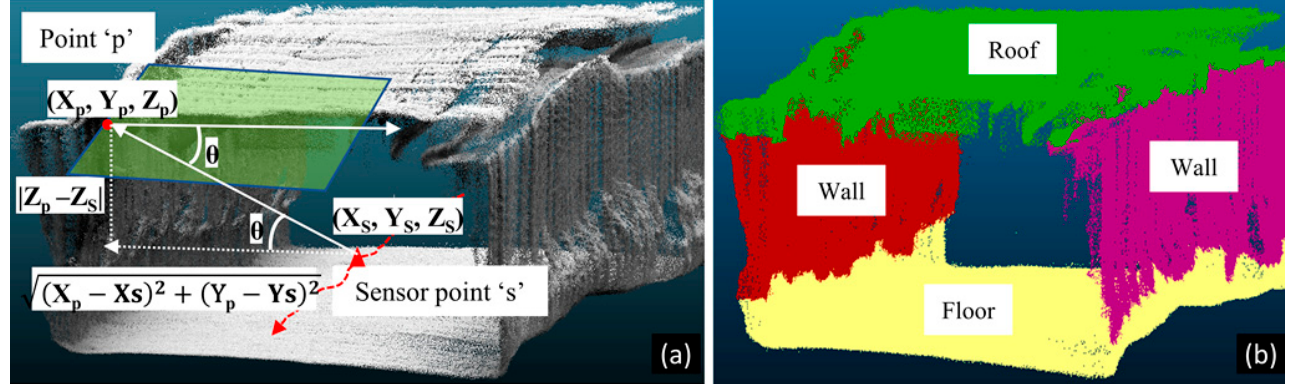
Figure 5. ( a ) Angle projected at a point between the nearest sensor location and the XY plane (shown with green shaded area). Whenever this angle was less than the specified threshold value, the point was stored. The process quickly segments the wall which may contain potential 3DUID. ( b ) The segmented roof, floor and walls shown with different colours for better visualisation.